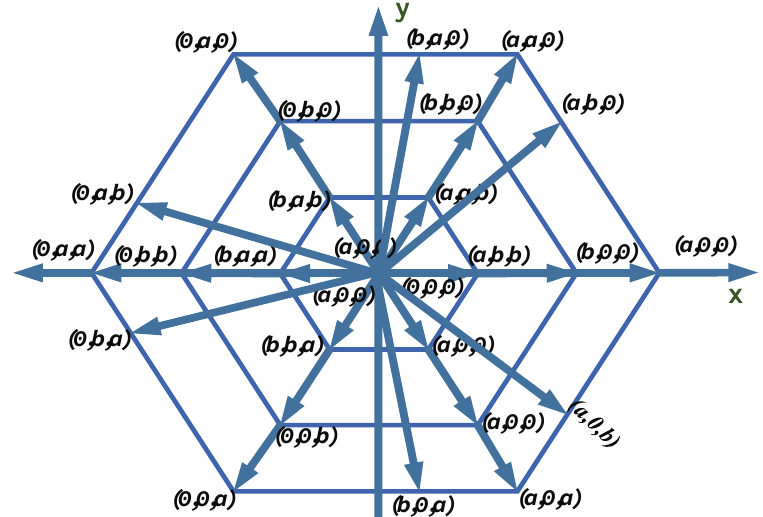
Figure 16. Voltage Space Vector for Multiport Converter [11].